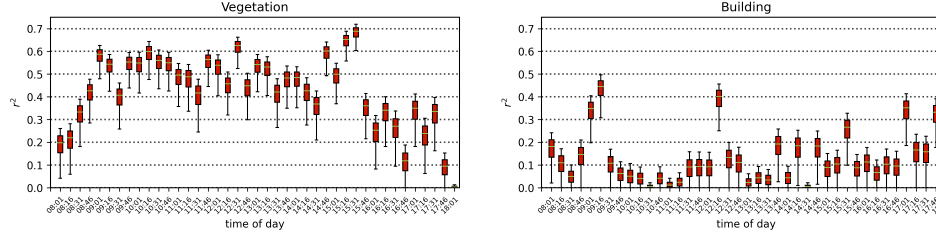
Figure 14. r 2 values that portray the levels at which linear models composed of O 3 , PM 2.5 , tempera- ture, and humidity are capable of explaining the variability in each series of standardized time-of-day Solar-Induced Fluorescence indicator ( SIFi ) for vegetation ( left ) and buildings ( right ).